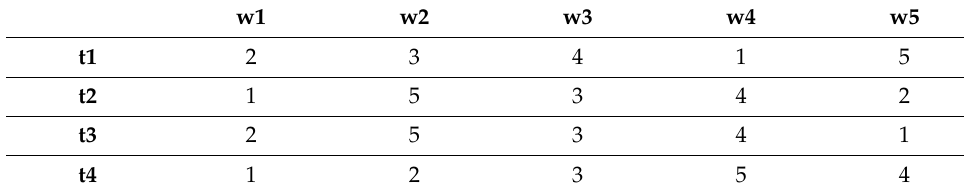
Table 3. Ranked task execution duration